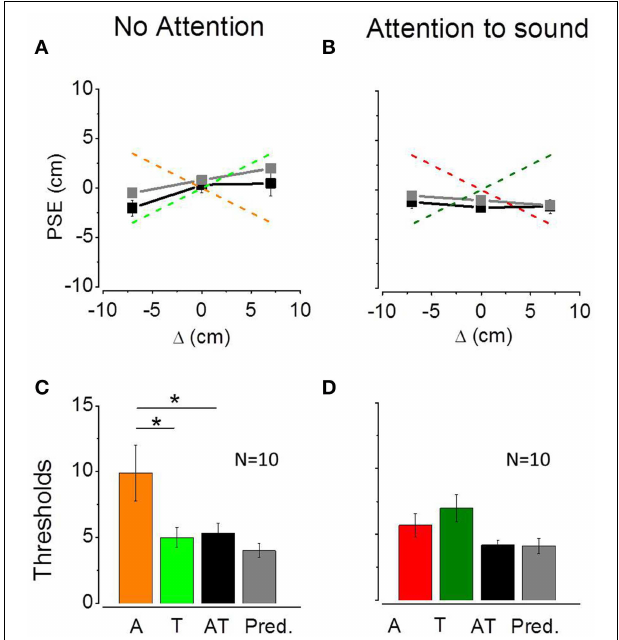
FIGURE 4 | (A,B) Average PSEs ( N 10 ) for the three bimodal conflicts = plotted as a function of the audio-tactile conflict ( 1 ) in the non-attentional condition (A) and in the attentional condition (B) . Error bars represent standard errors of the mean. Red and green lines describe the ideal performance in the case of auditory or tactile dominance, respectively. Black line and symbols show measured data, while gray line and symbols describe the model prediction. ( C,D) Average thresholds for the audio (A), tactile (T), and audio-tactile (AT) estimates and predicted bimodal thresholds in the non-attentional (C) and attentional condition (D) . Error bars represent standard errors of the mean. In the non attentional condition (C) auditory thresholds are different from tactile and bimodal thresholds ( * p - value < 0 . 05 ).